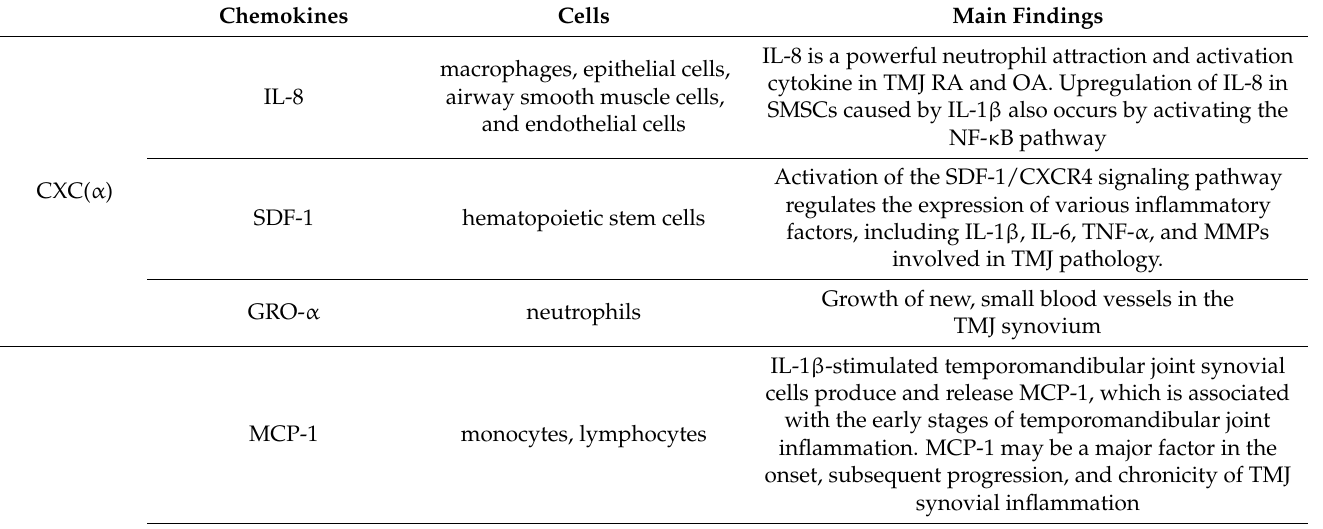
Table 1. Table summarizing the role of chemokine families in Temporomandibular Joint Disorder.